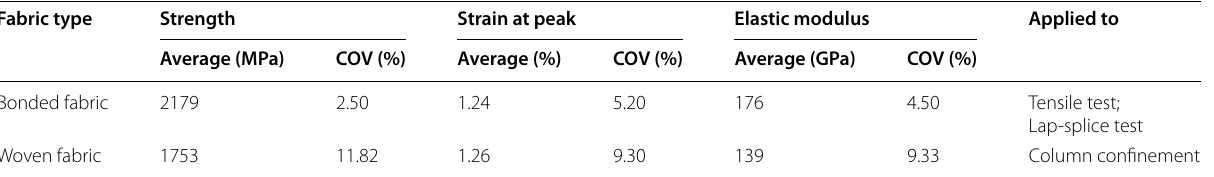
Average of ten tests for each type; density